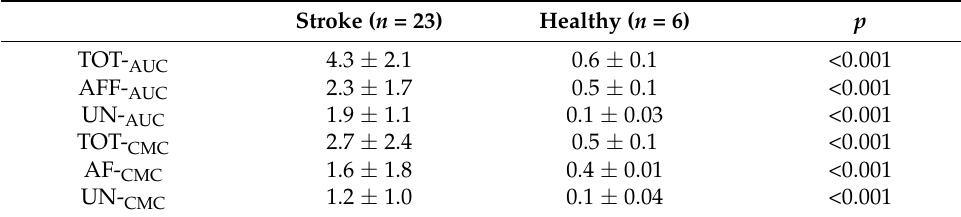
Table 2. Comparison between stroke patients and healthy subjects for AUC and